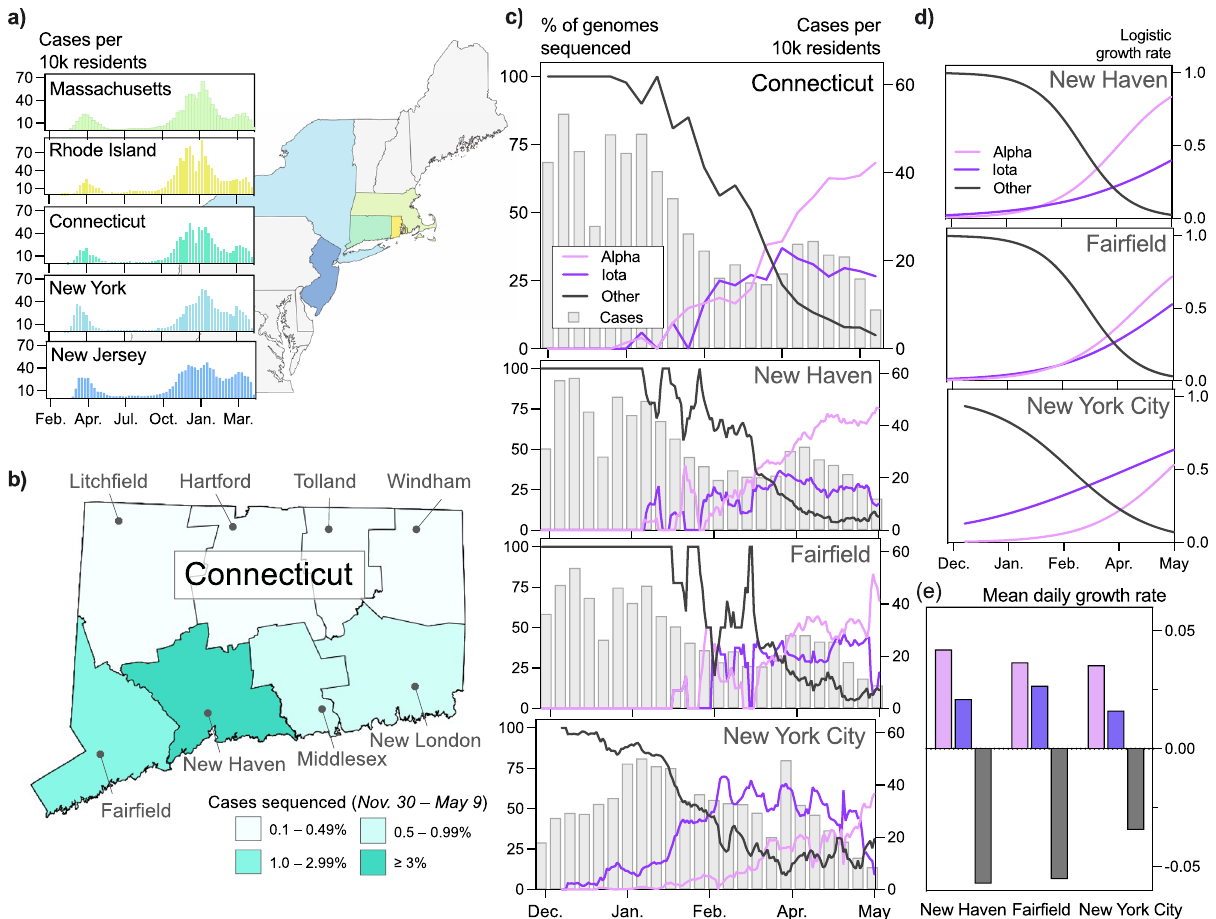
Fig. 1 Alpha and Iota dominated the circulating SARS-CoV-2 populations in Connecticut and New York City in early 2021. a Trends in COVID-19 incidence were consistent across northeastern states throughout the pandemic. (map) Connecticut (teal) is bordered by New York, Rhode Island, and Massachusetts. New York City is less than 50 miles from Fair fi eld County. Weekly COVID-19 incidence was tabulated according to the Johns Hopkins COVID-19 portal (https://github.com/CSSEGISandData/COVID-19). Shape fi le source: United States Census Bureau. b New Haven County led the state in the percentage of COVID-19 cases sequenced between November 30, 2020 and May 9, 2021 (3.33%). During this period, 0.51% of COVID-19 cases in New York City were sequenced. Genomes that were collected through targeted variant screening (e.g., spike -gene target failure) were excluded from this analysis. Shape fi le source: the Connecticut Department of Energy & Environmental Protection (DEEP) Geographic Information Systems Open Data Website. c Together, Alpha and Iota variants displaced nearly all other SARS-CoV-2 lineages in New Haven County ( n = 2086), Fair fi eld County ( n = 612), and New York City ( n = 4528). The lineages of sequenced viruses were assigned using pangolin v.2.4.2. The lineages B.1.526, B.1.526.1, and B.1.526.2 were assigned to the general lineage category ‘ Iota ’ . We calculated a 7-day rolling average for the proportion of Alpha, Iota, and ‘ other ’ SARS-CoV-2 lineages sequenced in our dataset. d Daily variant incidence estimated by fi tting a logistic growth model to the daily sequenced variant frequencies shown in c . This analysis was completed using Rv.4.0.1. Line colors correspond to the legend in c . e Daily growth rates of variants estimated using the logistic growth model shown in d . Bar colors correspond to the legend in c